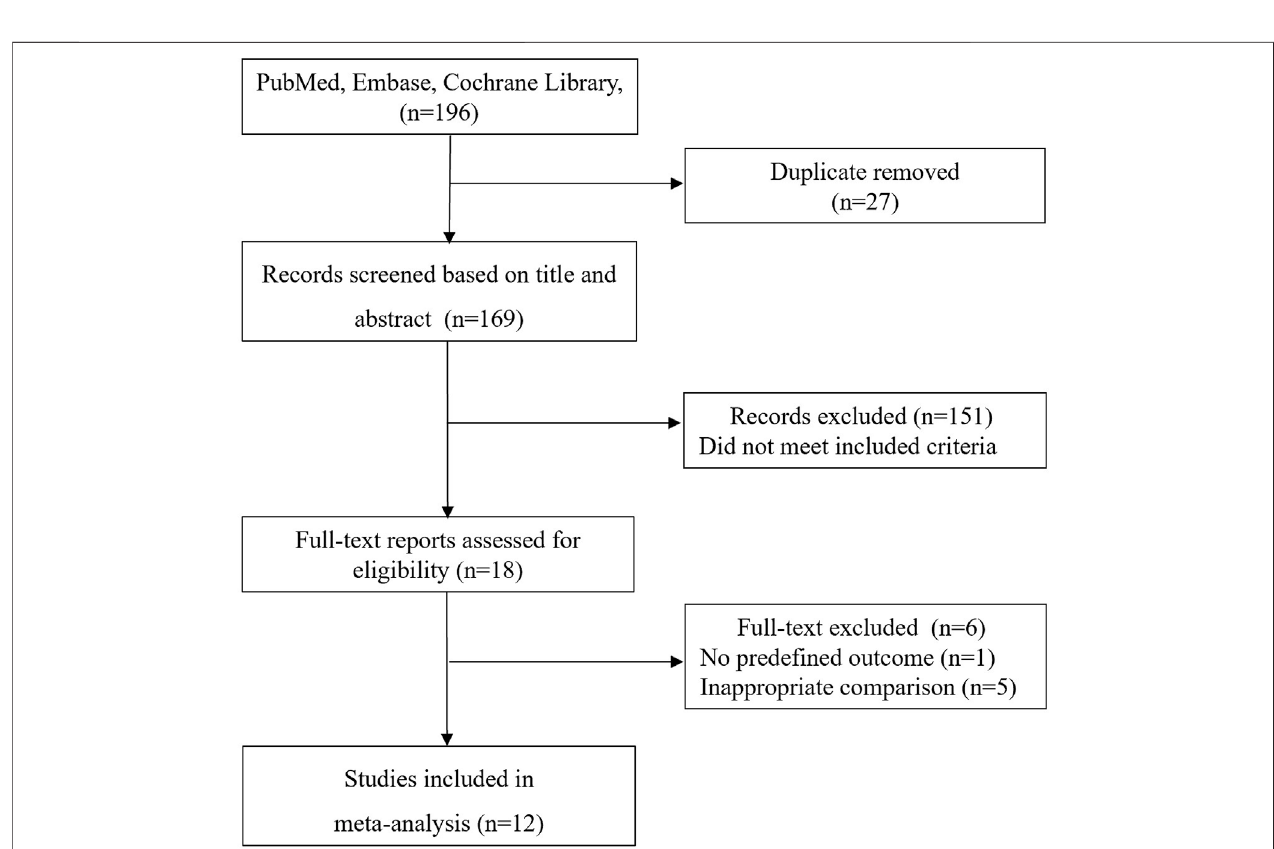
FIGURE3| Forestplotofcomparingprophylacticneuromuscular-blockingagenttowithoutneuromuscular-blockingagentregimeninpoorneurologicaloutcome.